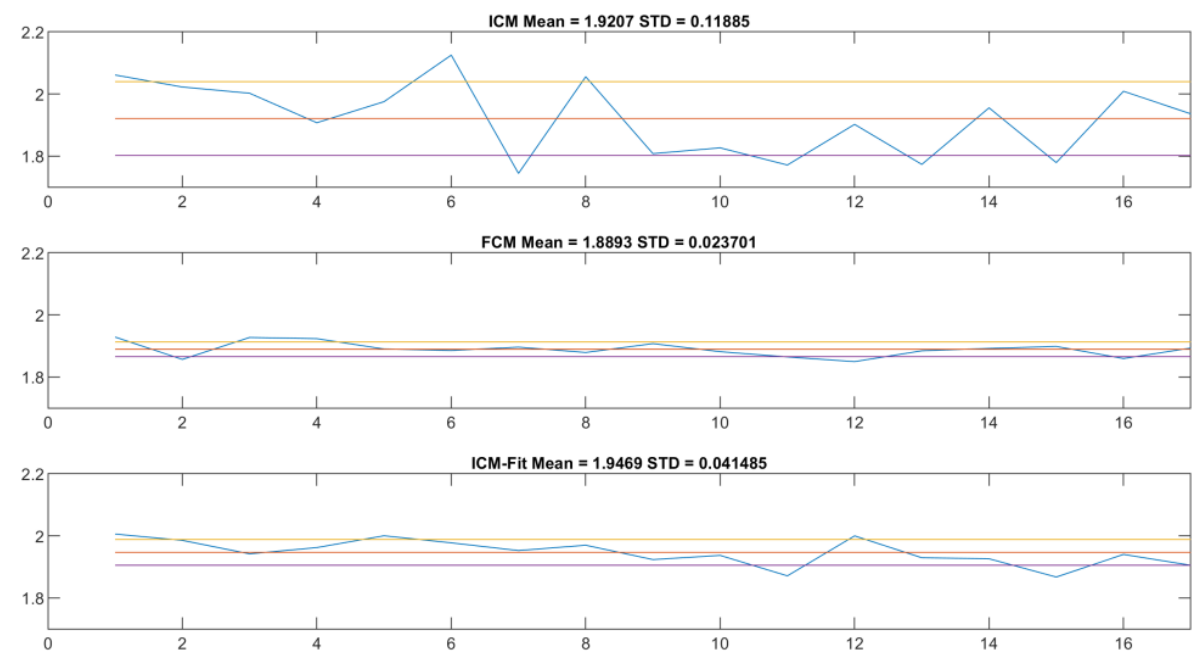
Figure 12. The ratio of the 2N and the 4N peak DNA content ratios for the histogram bin-based image cytometry ( top ), for flow cytometry ( middle ), and the reference and normal distribution fit-based image cytometry ( bottom ) results: The horizontal axis contains the 17 samples by index; the vertical axis shows the peak ratio value (the actual data with blue, the average with red, yellow and purple lines represent the ± 1 SD interval). The diagrams show the same range for comparison. The lower standard deviation of the bottom plot compared to the original ( top ) one is prominent.